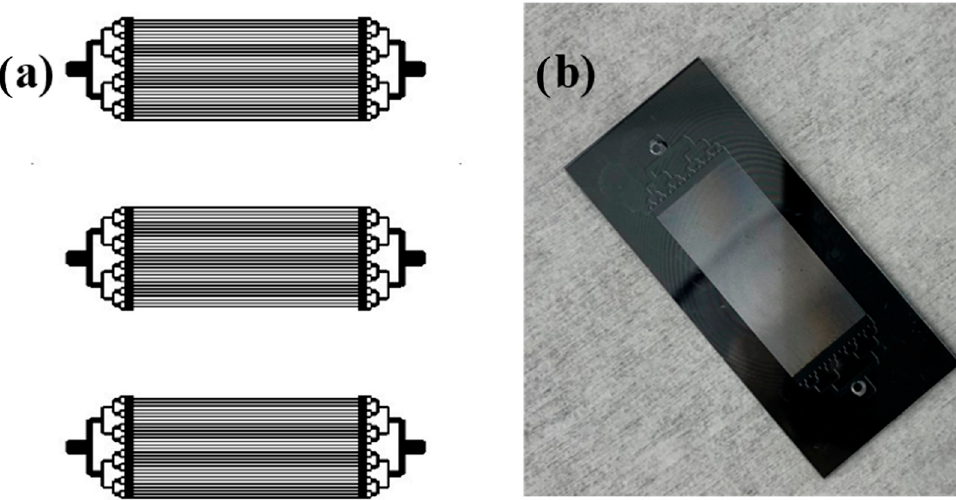
Figure 1. ( a ) AutoCAD design of a photomask and ( b ) an anodically bonded silicon microchannel microreactor .